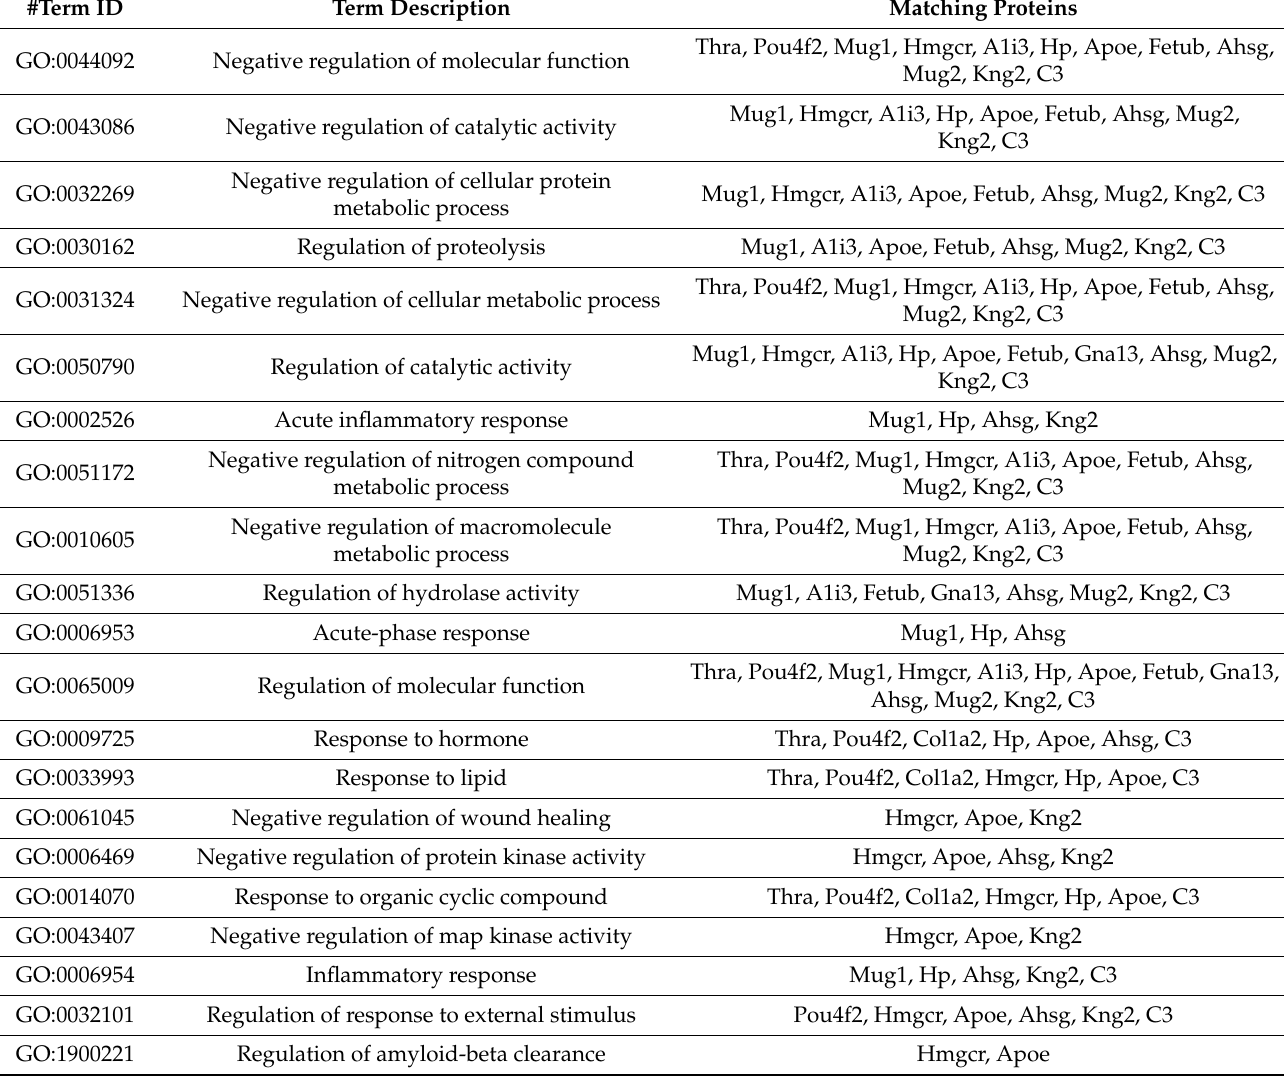
Table 2. List of significantly enriched biological processes in the biologically active fraction of the blood cell-derived secretome drawn from rats subjected to remote ischaemic